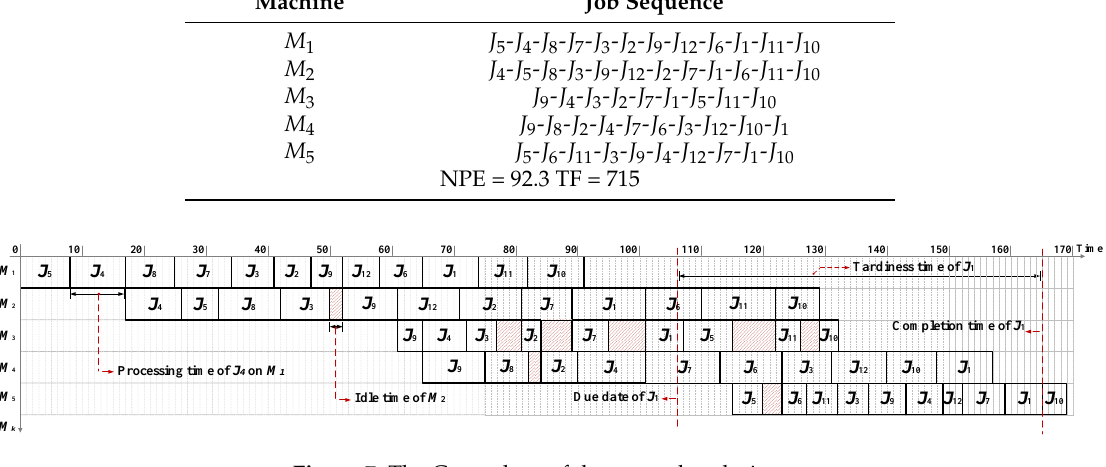
Figure 7. The Gantt chart of the example solution.